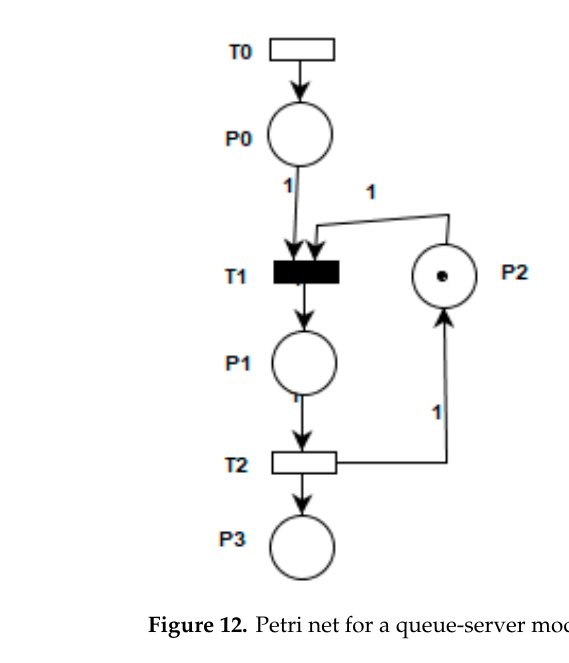
Figure 11. Synchronization with temporal entities in FlexSim.